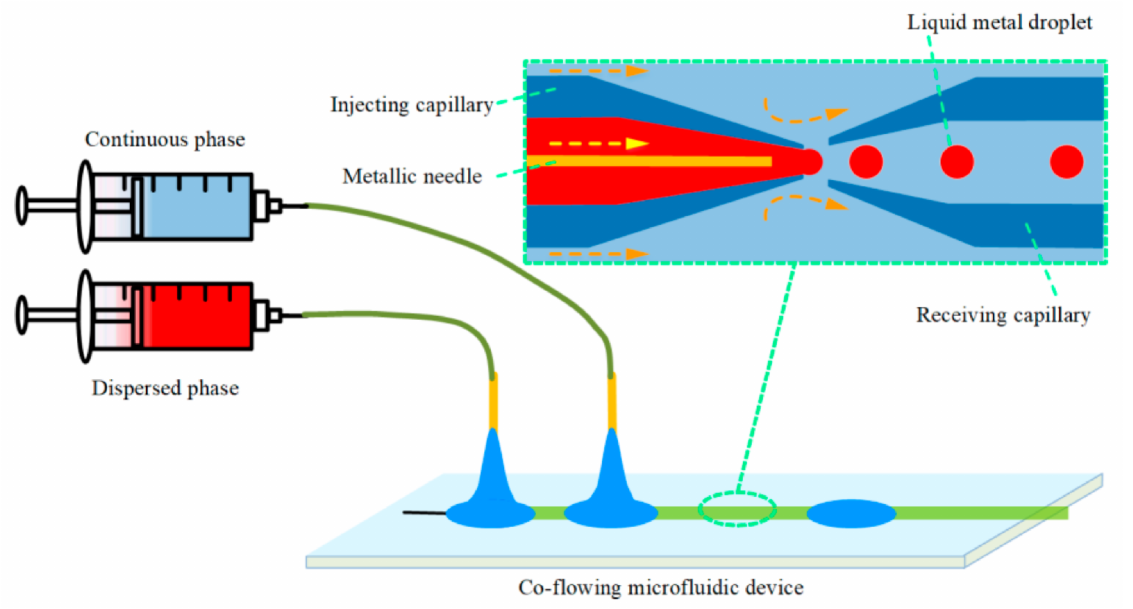
Figure 10. Schematic representation of the micro-needle induced co-flowing microfluidic experimen- tal setup. Reprinted from an open-access source [59].